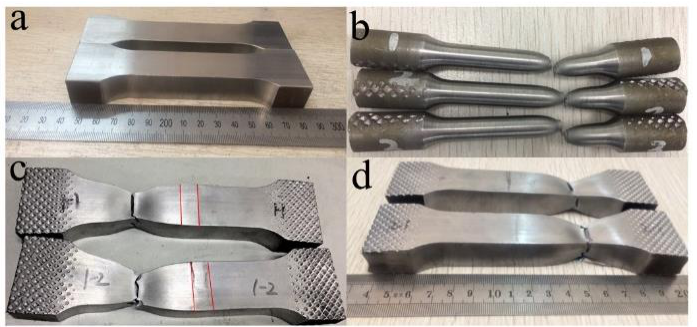
Figure 9. Tensile test samples; ( a ) samples before tensile test, ( b ) BM samples after test, ( c ) samples after test under welding condition, and ( d ) samples after test under quenching and tempering con-